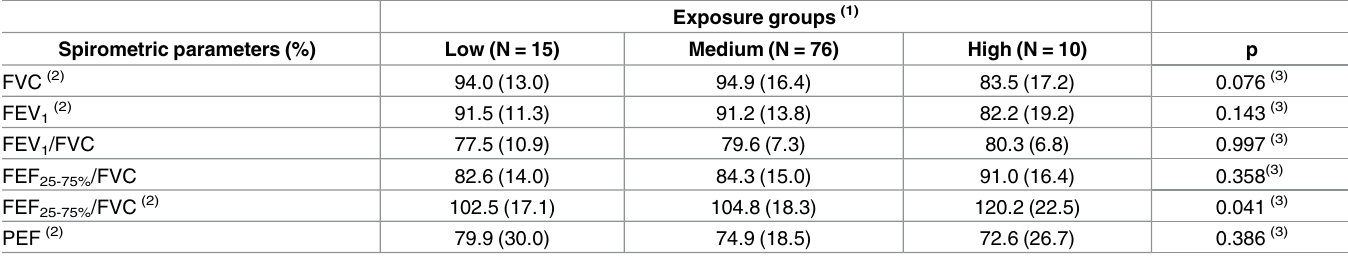
Table 2. Mean (standard errors) for the spirometric data of participants and p-values for the comparison of the exposure groups (N =